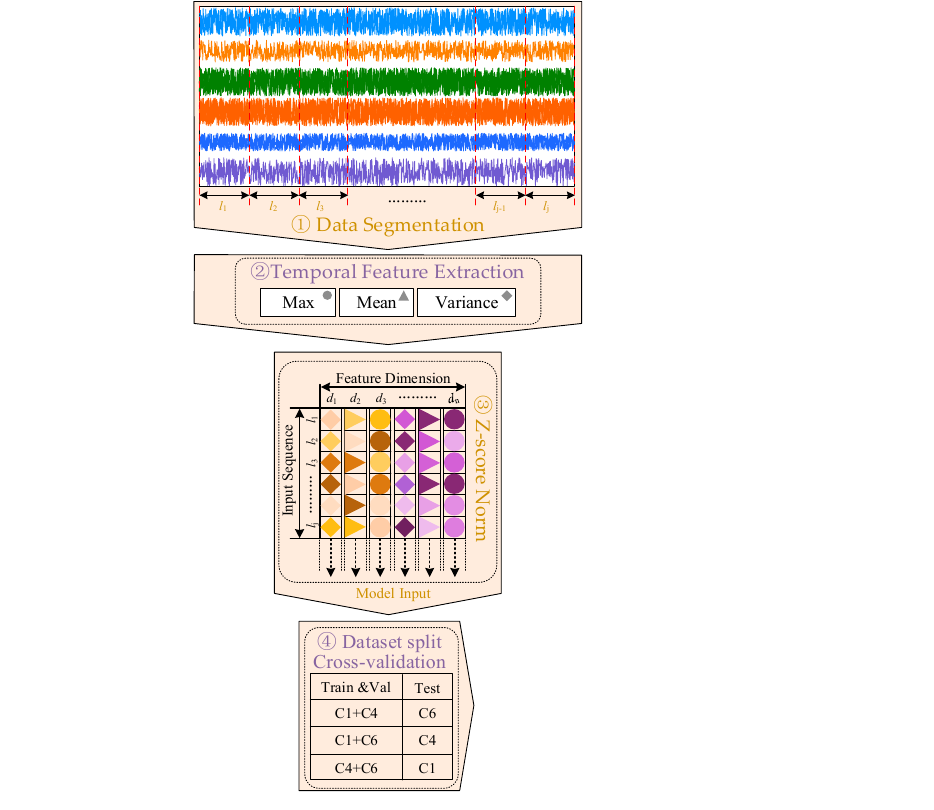
Figure 10. Data preprocessing program.